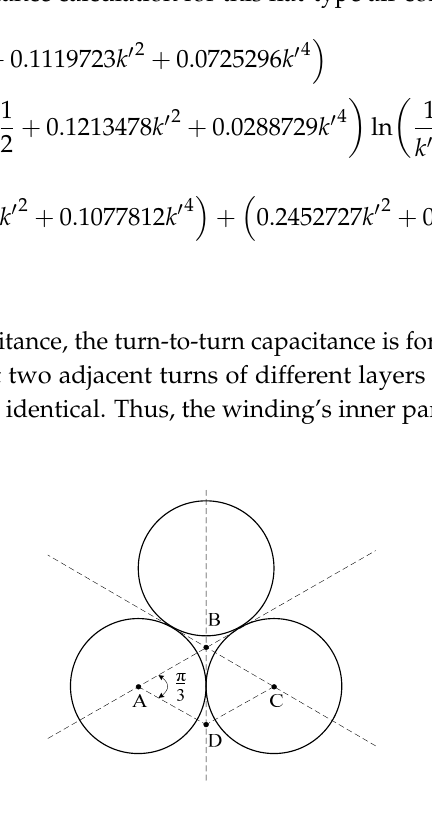
Figure 6. Representation of turn-to-turn capacitance for basic ABCD.